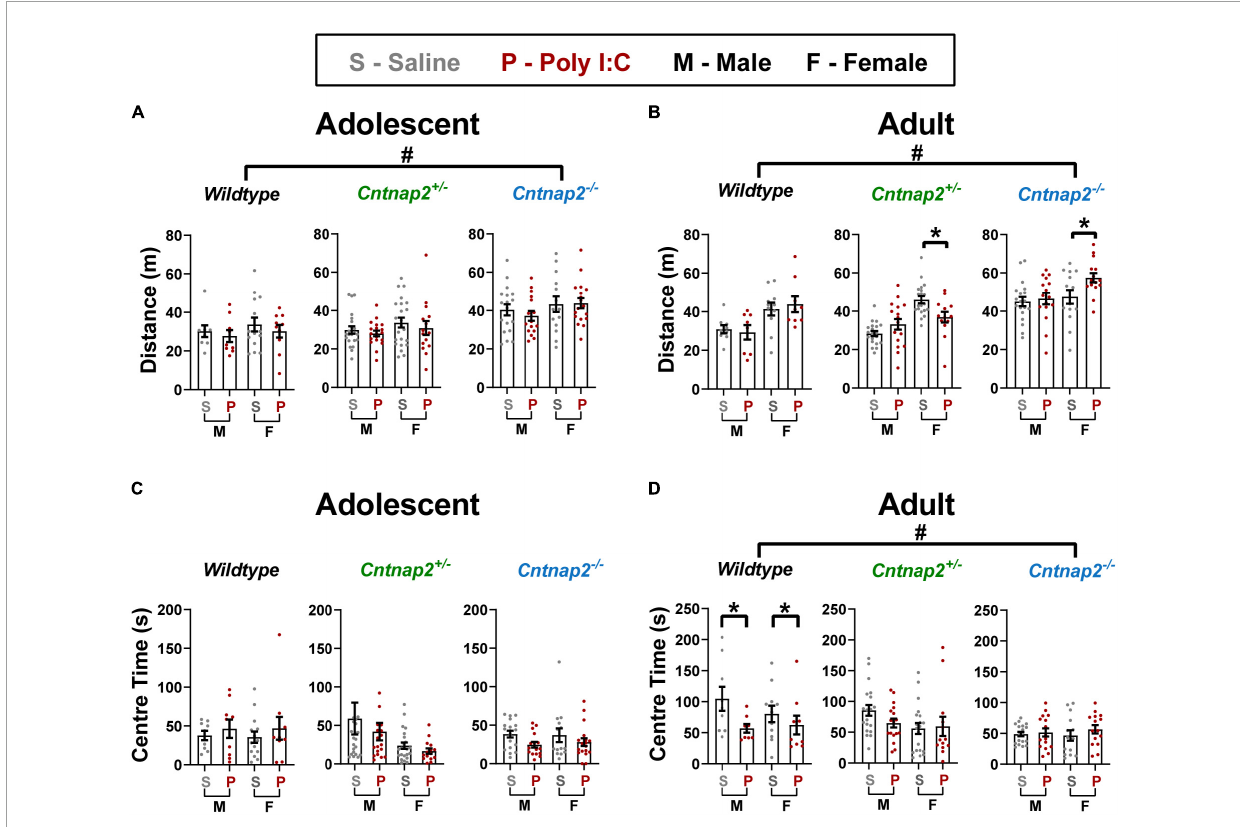
FIGURE6 Poly I:C MIA influences locomotor activity and anxiety in the open field in a sex and genotype-dependent manner, whereas full Cntnap2 deficiency induces changes in open field exploration in both adolescence and adulthood. (A) Adolescent Cntnap2 − / − offspring show hyperactivity measured by total distance traveled in the open field compared to WT and Cntnap2 + / − offspring at 6 weeks of age ( p < 0.001 for both comparisons; indicated by the # symbol). (B) In adulthood, Cntnap2 − / − hyperactivity persists ( p < 0.001 for both comparisons; indicated by the # symbol), but Poly I:C MIA leads to reduced activity in Cntnap2 + / − females ( p = 0.019) and increased activity in Cntnap2 − / − females (0.013; both Poly I:C effects indicated by the ∗ symbol). (C) Anxiety as measured by time spent in the center is not altered by either Cntnap2 deficiency or Poly I:C MIA in adolescence. (D) In adulthood, Poly I:C WT offspring show reduced center time compared to WT saline offspring ( p = 0.008; indicated by the ∗ symbol), but Poly I:C MIA has no effects on Cntnap2 + / − or Cntnap2 − / − offspring. Additionally, Cntnap2 − / − offspring show significantly decreased center time compared